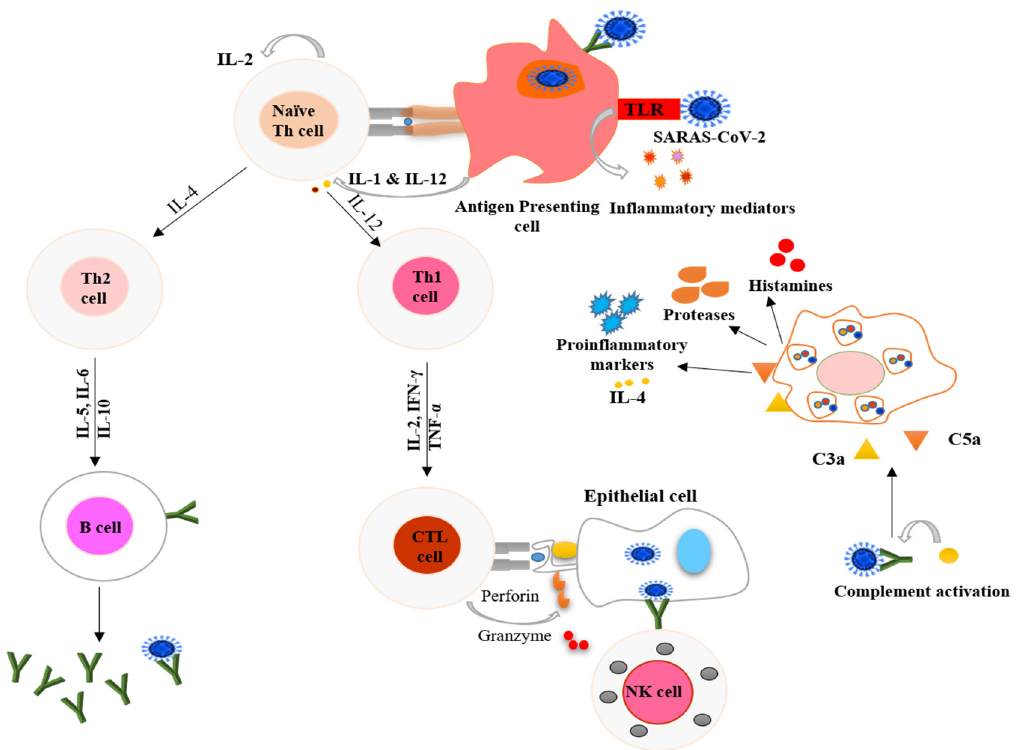
Figure 1. Schematic representation of processes used by the host immune system to combat COVID-19. The antigen-presenting cells (dendritic cells and macrophages) present the virus to naïve Th cells and stimulate the adaptive immune system. T cells also signal monocytes and macrophages to attract them to the infection site, where they release chemokines. Toll-like receptors (TLR) present on antigen-presenting cells recognize specific receptors on the virus and secrete inflammatory markers in innate immune system response. Mast cells activated by the pathogen release proinflammatory markers, proteases, and histamines. The upregulated secretion of proinflammatory markers causes a cytokine storm. IL-1 = interleukin 1; IL-2 = interleukin 2; IL-12 = interleukin 12; IL-4 = interleukin 4; IL-5 = interleukin 5; IL-6 = interleukin 6; IL-10 = interleukin 10, IFN- γ = interferon gamma; TNF- α = tumor necrosis factor alpha; CTL = cytotoxic T lymphocytes; NK = natural killer; C3a = complement component 3a; and C5a = complement component 5a.